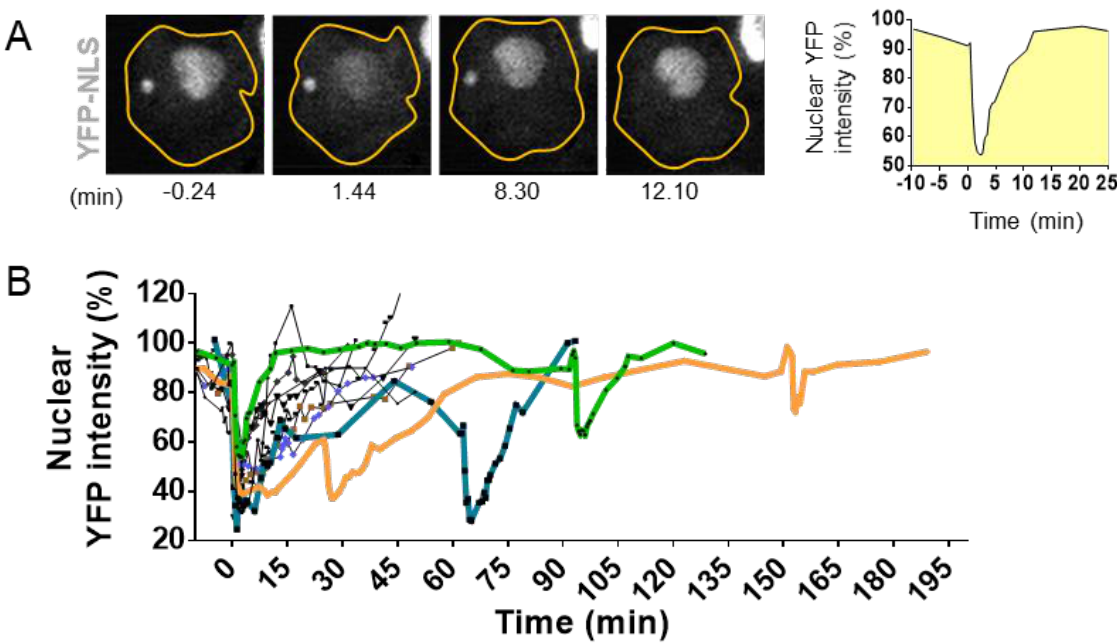
Figure 4. Visualization and quantification of nuclear envelope disruption (NED). ( A ). Time lapse imaging of migrating MCF10A cells treated with TGFß and stably expressing the fluorescent markers YFP linked to the Nuclear Localization Signal (YFP-NLS) [74]. Confocal imaging in YFP channel and bright field allows the visualization of sudden leakage of YFP-NLs into the cytoplasm, showing a loss of proper compartmentalization of the nucleus during 8.30 mn and the loss of compartmentalization of the micronuclei at 12.10 mn of time. ( B ). Graph shows nuclear fluorescence intensity changes upon time in 10 cells with events of interphase NED/nuclear envelope repair observed in TGFß-treated MCF10A cells. Bold colored lines highlight repetitive NED events from the same cell. Adapted from Comaills et al. [10].